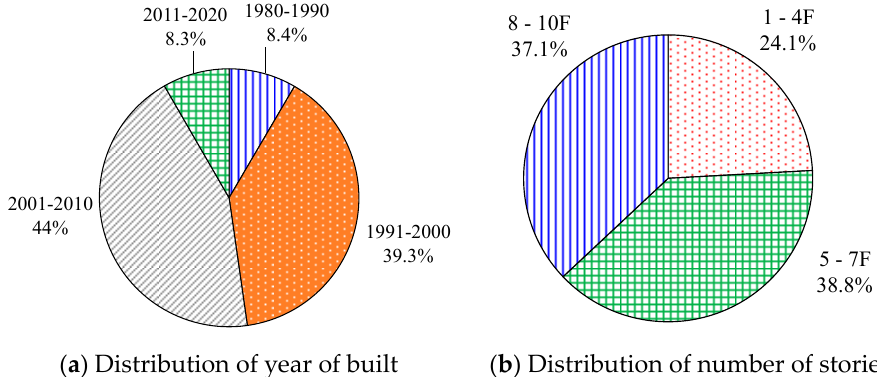
Figure 11. Building information of the studied area: ( a ) Distribution of year of built; ( b ) Distribution of number of stories.